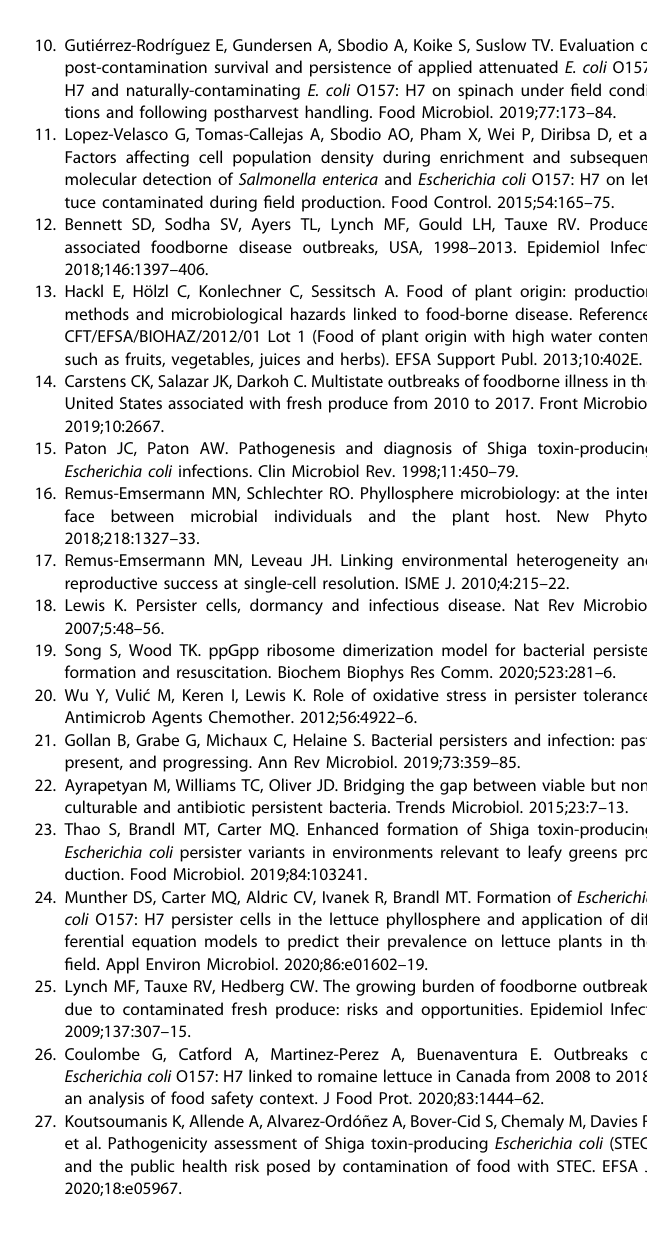
Fig. 3 Schematic diagram illustrating mechanistic model prediction of switch rate from normal to persister cell and correlation analysis with weather factors; increased solar radiation intensity promoted the persister switch rate in both E. coli and Salmonella on leaves. On the contrary, increased wind speed inhibited the persister switch rate in E. coli , and increased RH, temperature, and dew point similarly had a negative effect on the persister switch rate in Salmonella